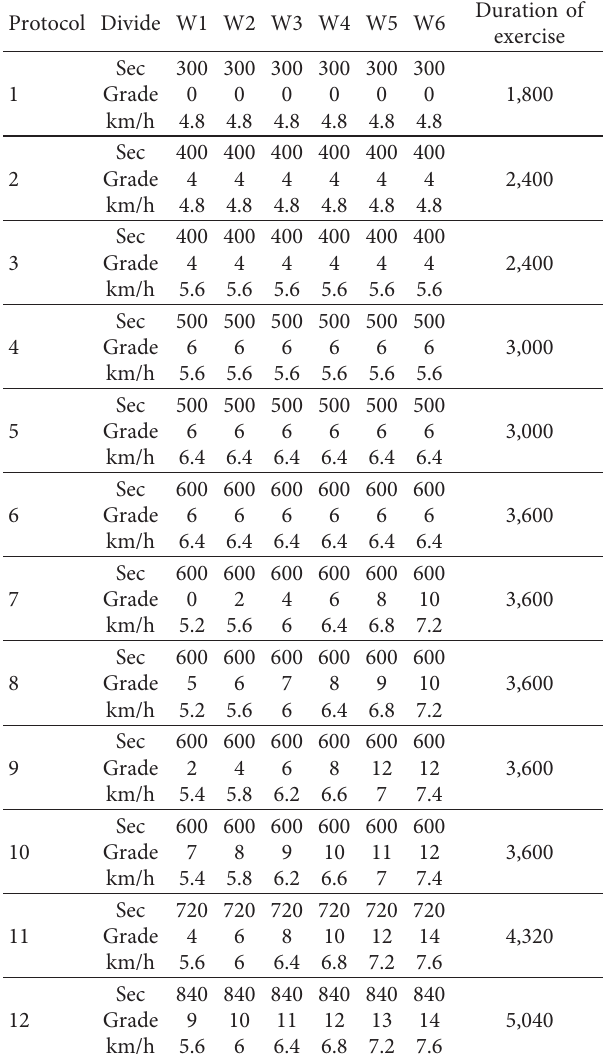
Table 2: Continuous exercise program consisting of 12 protocols. Protocol Divide W1 W2 W3 W4 W5